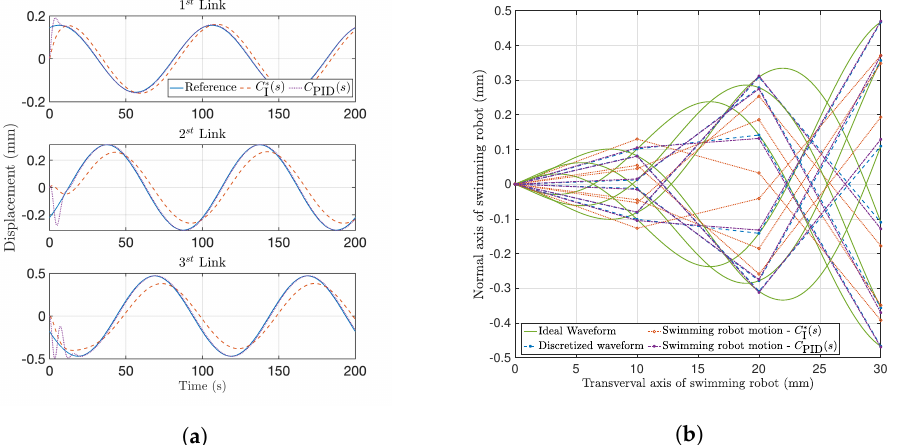
Figure 12. Swimming robot motion: ( a ) tracking results for the three robot links, ( b ) comparison of the ideal, discretized, and realized linear Carangiform